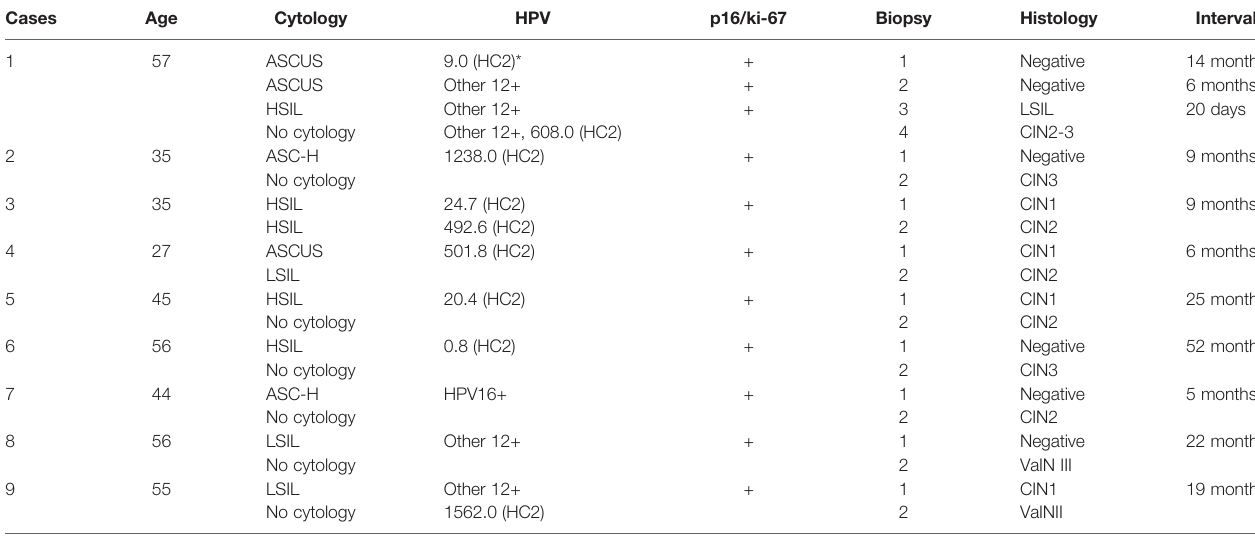
TABLE 6 | Patients positive for p16/ki-67 and cytology, but no CIN 2+ characteristics in histology.